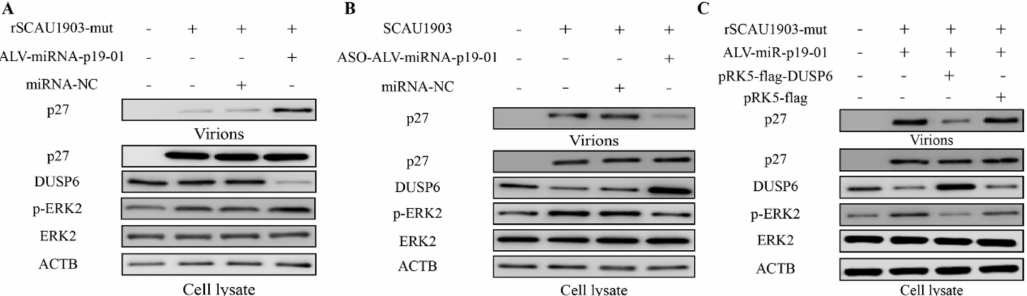
Figure 6. ALV-miR-p19-01 promotes viral replication via activating DUSP6/ERK2 pathway. ( A ) DF-1 cells respectively transfected with ALV-miRNA-p19-01 mimic and miR-NC were infected with ALV-J rSCAU1903-mut at 4 hpt. ( B ) DF-1 cells respectively transfected with ASO-ALV-miRNA- p19-01 mimic and ASO-NC were infected with ALV-J SCAU1903 at 4 hpt. ( C ) DF-1 cells were co-transfected with ALV-miRNA-p19-01 mimic and pRK5-flag-DUSP6, and then DF-1 cells were infected with ALV-J rSCAU1903-mut at 4 hpt. The expressions of p27, DUSP6, ERK2, p-ERK2 and β -actin were detected by Western